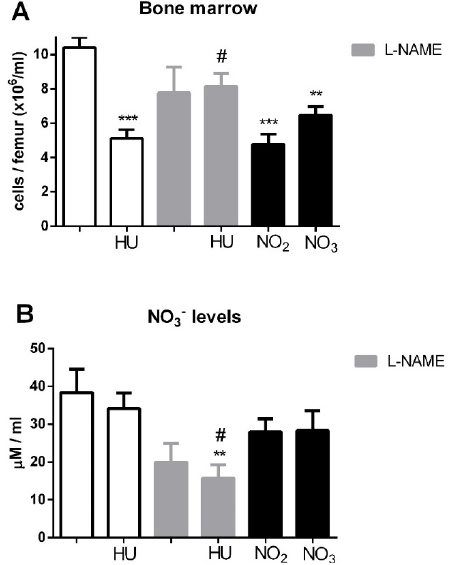
Figure 5. Hydroxyurea and NO derivatives’ induction of mouse bone marrow cells and NO